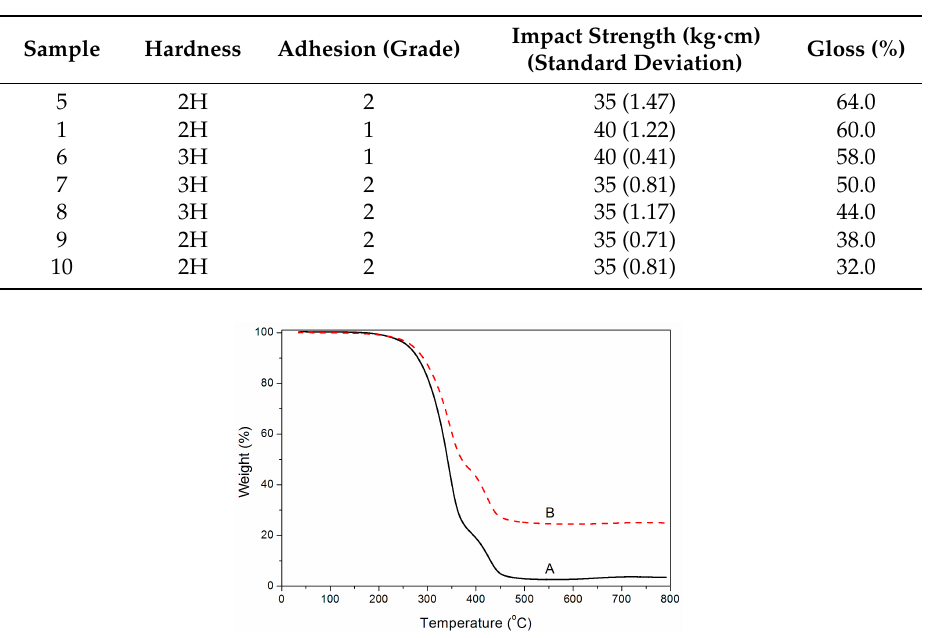
Table 5. Effect of talcum content on properties of the coating during the synergistic effect (samples 1 and 5–10 in Table 1).